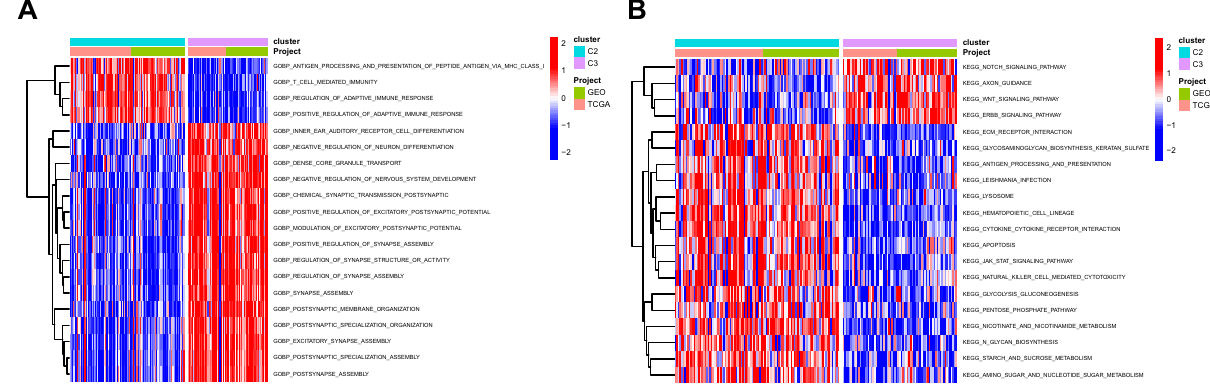
Figure 3. Differentially analysis of enriched functions between C2 and C3. ( A ) Heatmap illustrating the differentially enriched biological process between C2 and C3 clusters. ( B ) Heatmap illustrating the differentially enriched KEGG pathways between C2 and C3 clusters. KEGG: Kyoto Encyclopedia of Genes and